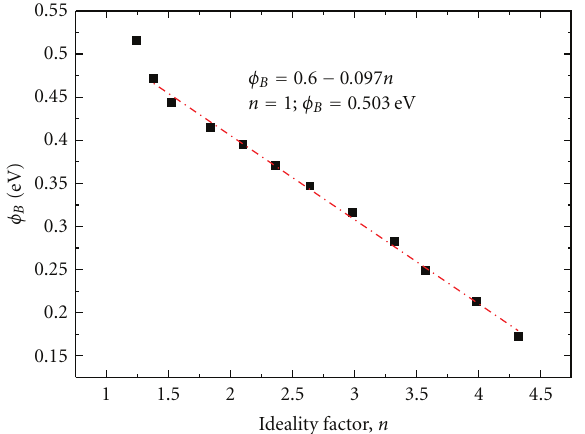
Figure 5: Barrier height versus ideality factor of the Al/HfO 2 /p-Si (MOS) structure at various temperatures.